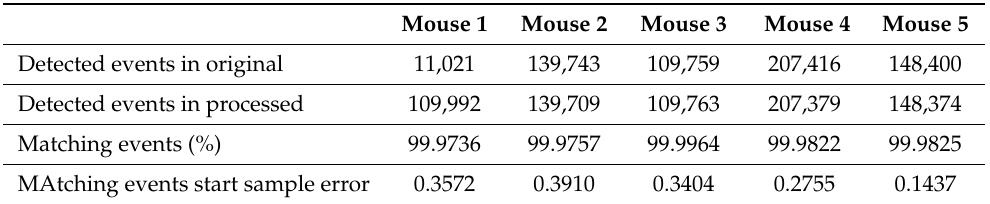
Table 3. Events were detected by spike sorting software in raw and processed signals from five different